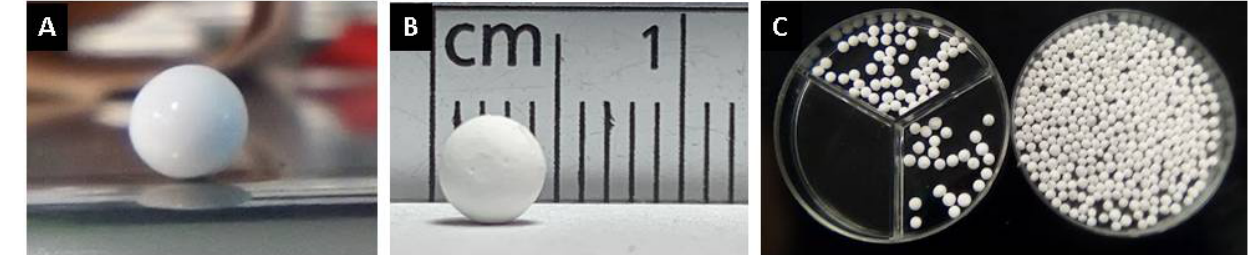
Figure 1. Photographs of alumina spheres: ( A ) without thermal treatment, ( B ) with treatment at 1600 °C and ( C ) several spheres at 1600 °C in petri dish.